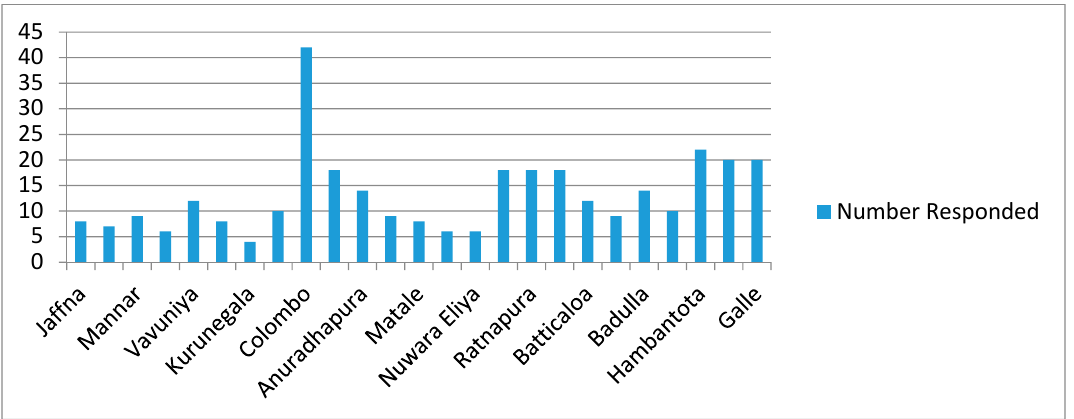
Figure 6. Number of responses to questionnaire (Source: Survey data).